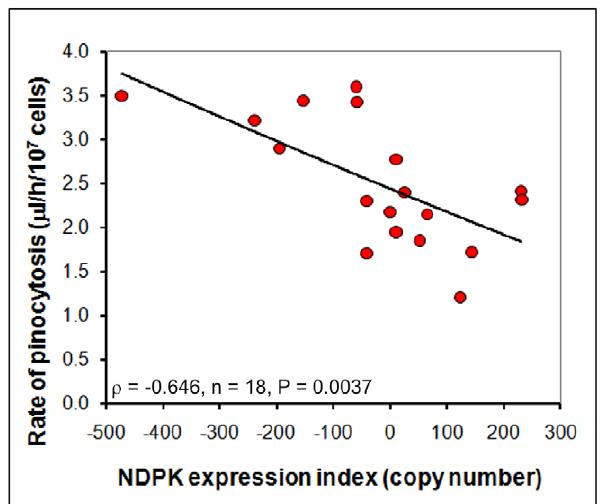
Figure 9. NDPK inhibits macropinocytosis. The ability of axenically growing cells to uptake FITC-dextran was measured and plotted against the NDPK expression index (defined as in Fig. 5). Macropinocytosis rates declined as NDPK expression levels increased. The correlation was significant at P , 0.01 (Pearson product-moment correlation coefficient r ). Duplicate measurements were made in each of three experiments for each transformant and the overall mean from all three experiments was